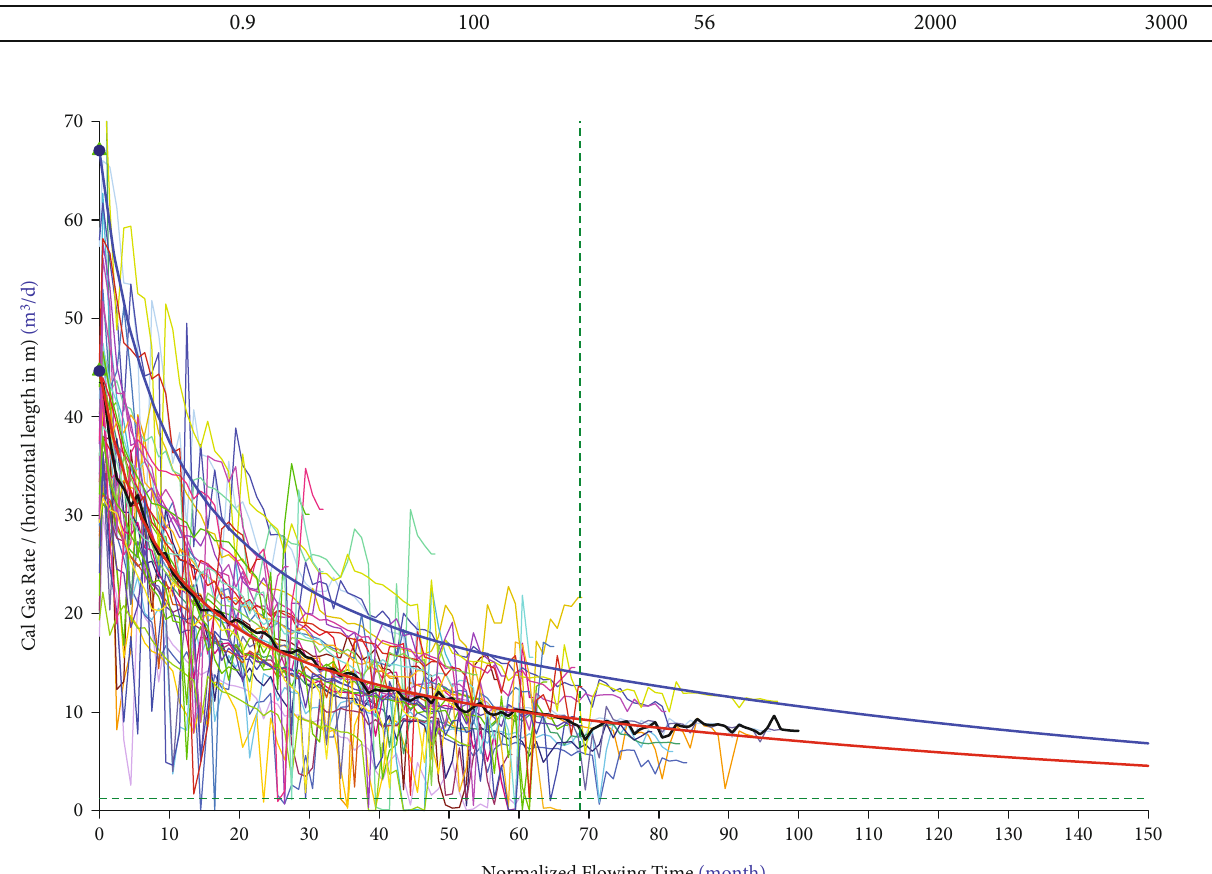
Figure 9: Prediction of gas rate per meter in the lower layer in the S block. The bold black curve is the average unit lateral length obtained using the original drilling and completion technique, the bold red curve is the type well of the unit lateral length obtained using the original drilling and completion technique, the bold blue curve is the type well of the unit lateral length obtained using the designed drilling and completion technique, the horizontal green dashed line indicates the economic limit production per unit lateral length, and the vertical green dashed line indicates the boundary point between hyperbolic decline and exponential decline.